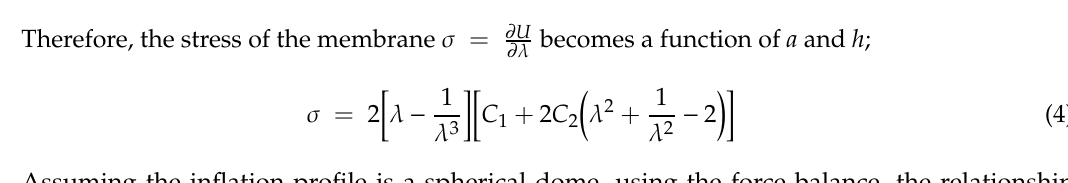
Figure 2. Schematic diagram of the mathematical representation of the inflation of the mini-bladder.